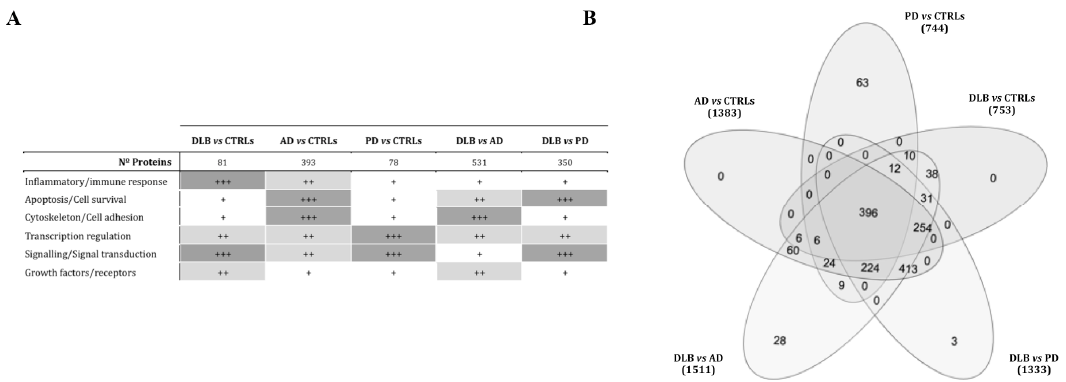
Figure 6. Target prediction analysis for the 5 miRNA sets was performed with miRTarbase and miRGate online tools. ( A ) Most relevant targeted pathways, according to Reactome and String analysis for each target-gene list. Mostly, genes related to transcriptional regulation and signal transduction were overrepresented (+++, ≥ 40% of the pathways related; ++, 20–40% of related pathways; +, up to 20% of the defined pathways). ( B ) Venn diagram comparing altered pathways in the 5 miRNA sets defined. In PD, 63 pathways were specifically altered, and 31 were associated with DLB in comparison to AD and PD.